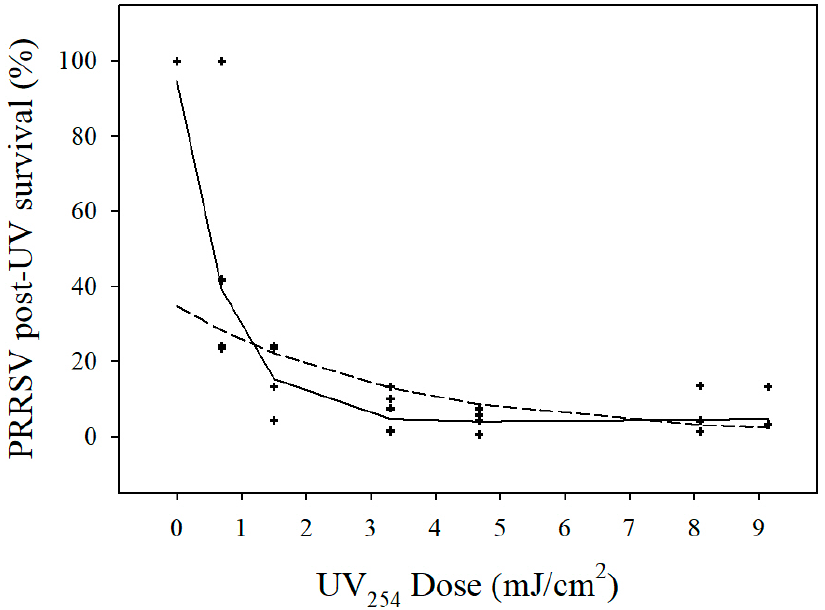
Figure 2. UV ‐ C (254 nm) treatment inactivation of aerosolized PRRSV. PRRSV post ‐ UV survival (%) = N t /N 0 . A log10 normalized PRRSV post ‐ UV survival is shown in Figure A1. One ‐ stage and two ‐ stage inactivation models are marked with dashed and solid lines, respectively.